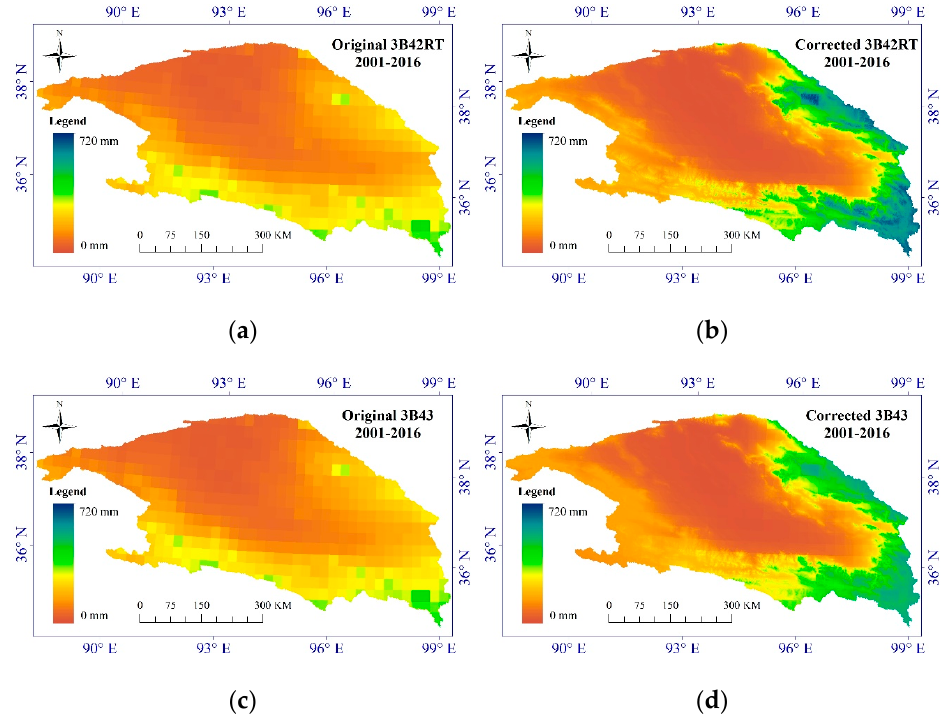
Figure 7. Comparison of spatial distribution of TRMM precipitation before and after correction. ( a ) Original 3B42RT precipitation; ( b ) Corrected 3B42RT precipitation; ( c ) Original 3B43 precipitation; ( d ) Corrected 3B43 precipitation.